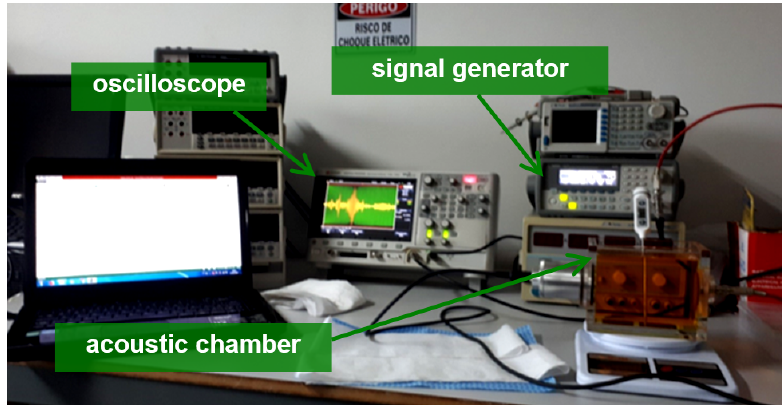
Figure 7. Experimental setup.